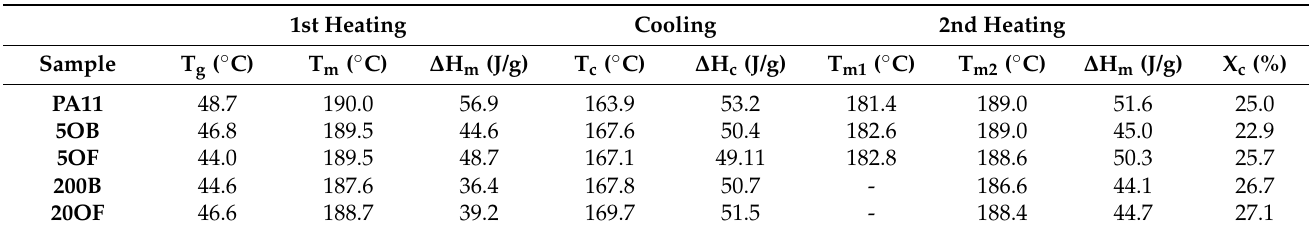
Table 8. Thermal characteristics of PA11 and biocomposites based on PA11 with different weight fractions of